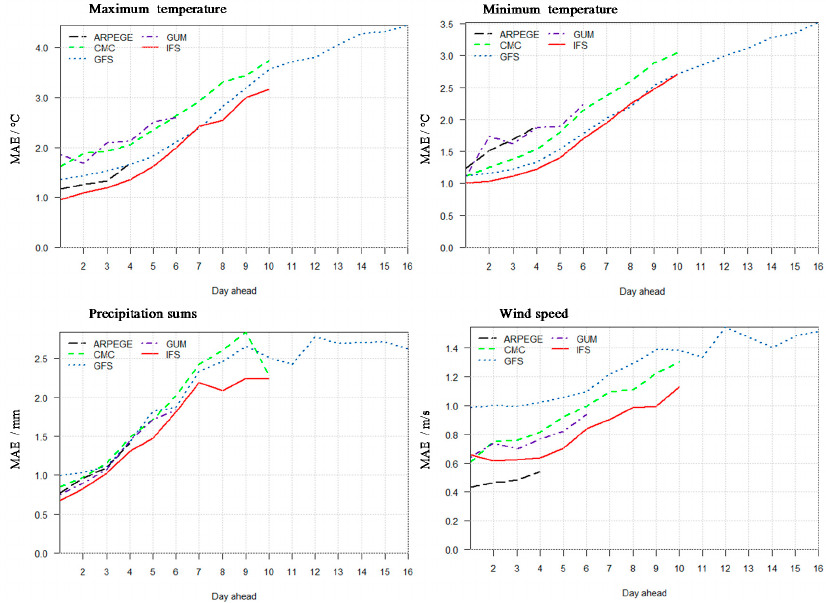
Figure 4. MAE (mean absolute error) as difference between forecast and measured meteorological element for maximum air temperature ( upper left ), minimum air temperature ( upper right ), precipitation sums ( bottom left ), and wind speed ( bottom right ) for the given number of days ahead (horizontal axis). Geosciences 2018 , 8 , x FOR PEER REVIEW